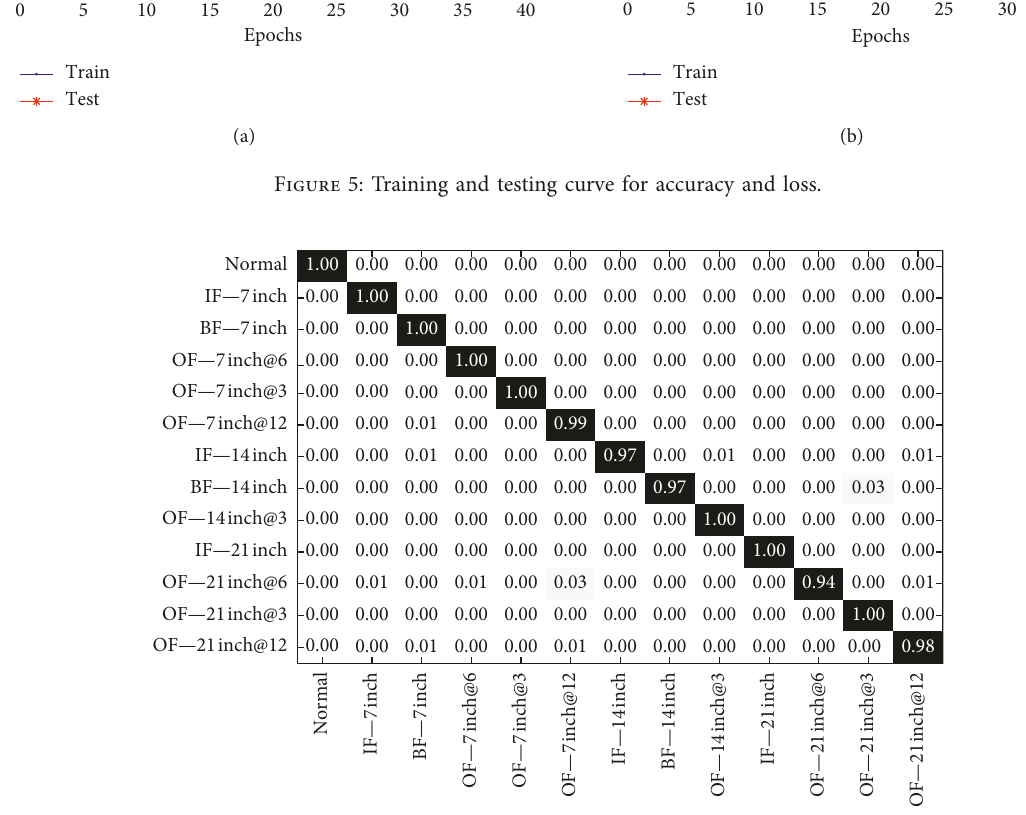
Figure 6: Confusion matrix for each